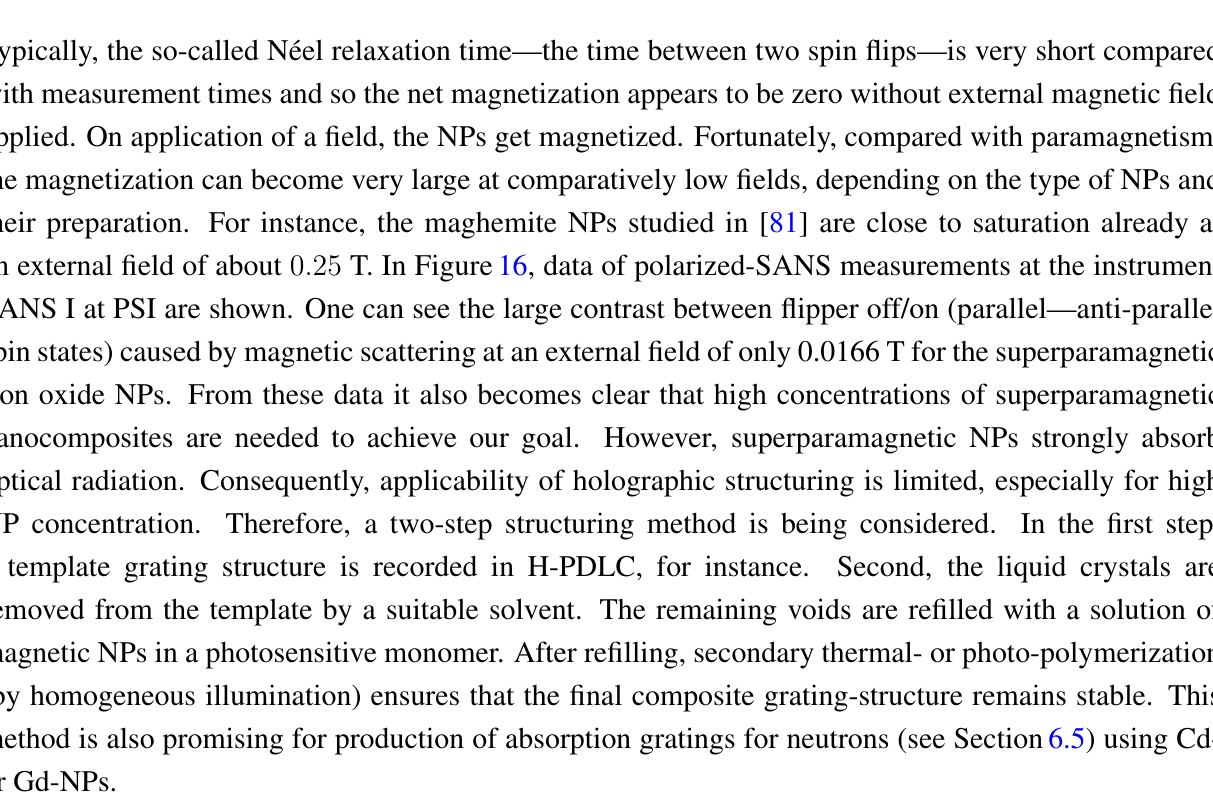
Polarized-SANS diffraction patterns of ( a ) superparamagnetic iron